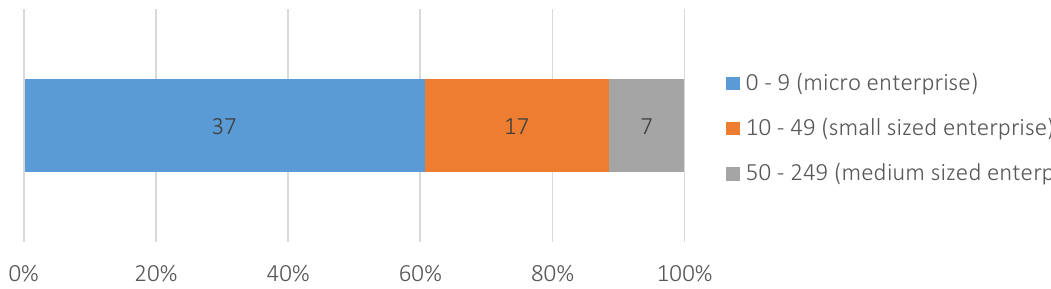
Figure 1. Categories of SMEs funded by venture capital in the research sample according to number of